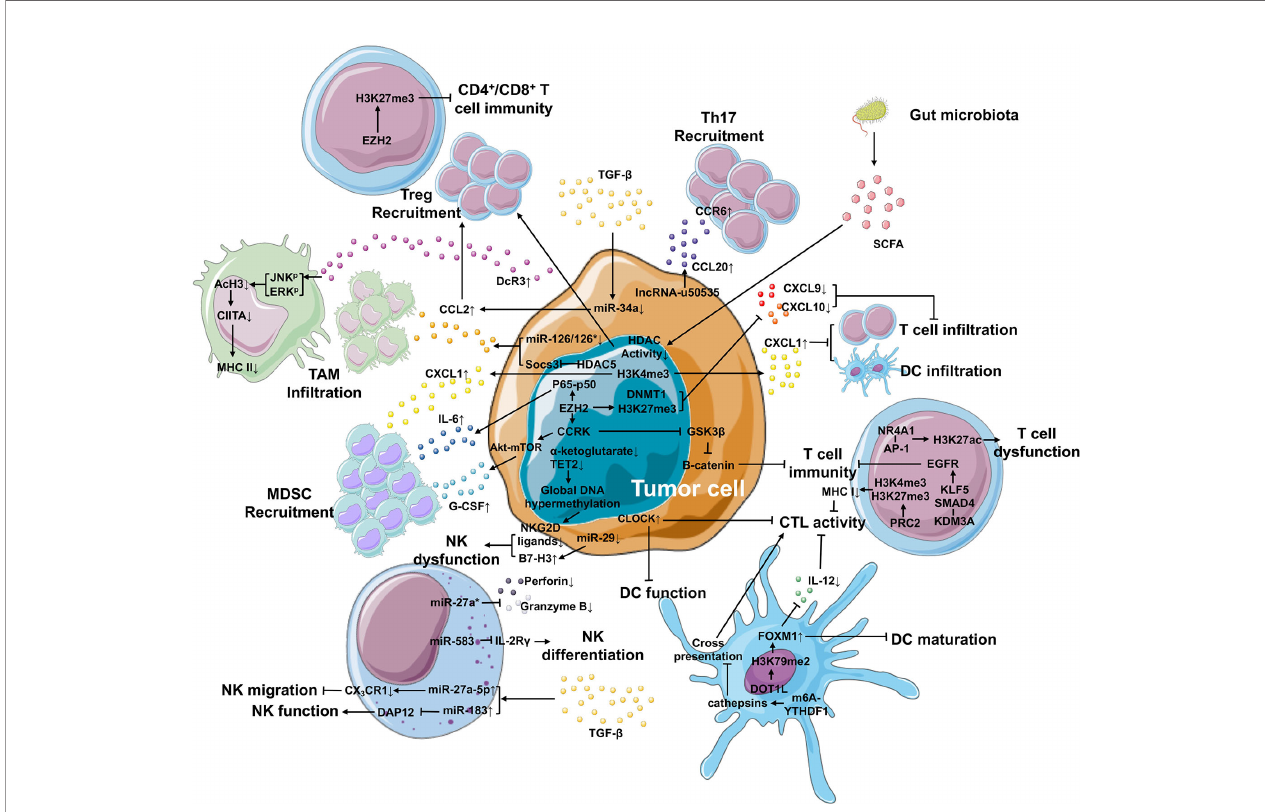
FIGURE 2 | Epigenetic mechanisms in the TIME that contributes to cancer development. Within the TIME, epigenetic regulation plays an important role in generating immunosuppressive environment and facilitating tumor differentiation. In tumor cells, epigenetic regulation is involved in the upregulation of IL-6 and G-CSF and the downregulation of CXCL9 and CXCL10 via EZH2, as well as the elevated expression of CXCL1 secreted by tumor cells via H3K4me3, leading to improved MDSC recruitment and repressed T cell or DC in fi ltration, respectively. The expression of CCL2 (responsible for the recruitment of TAM and Treg cells) and CCL20 (responsible for Th17 recruitment) is enhanced by miR-126/126* or miR-34a and lncRNA-u50535, respectively. Furthermore, tumor cells can suppress the function of macrophage-, NK cell-, DC- and T cell-mediated immunity through other epigenetic mechanisms. In the TIME, high TGF- b levels can be produced by not only tumor cells, but also other cell types. TGF- b can regulate the expression of miRNAs in tumor cells and NK cells, suppressing NK migration and function and Treg recruitment. What ’ s more, the gut microbiota releases SCFA that inhibits the activity of HDACs, further improving the recruitment of Treg